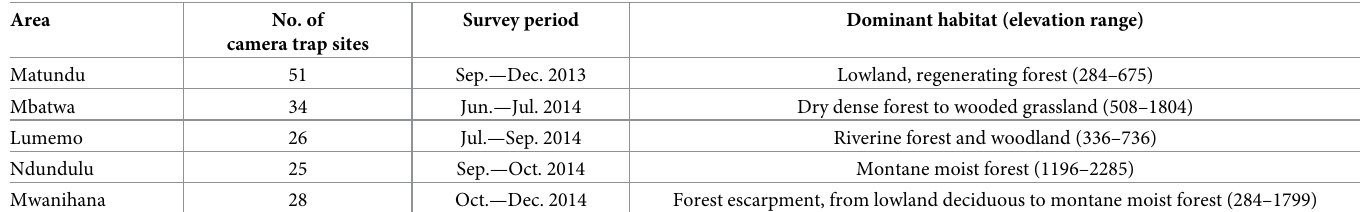
Table 1. Survey effort and areas. Survey effort for the five areas in the Udzungwa Mountains, Tanzania, sampled with camera traps. These areas hold broadly different habitat types, as indicated in table; the elevation range (in m a.s.l.) is related to sampling sites.